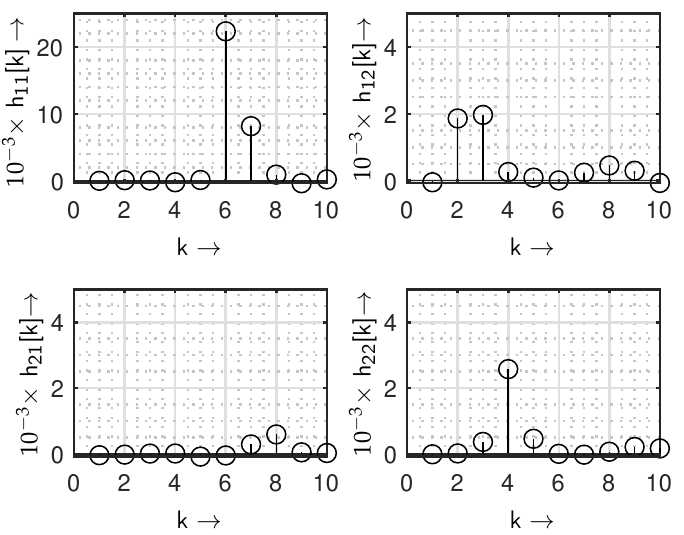
Figure 3. Measured channel impulse response of a 100 m long MMF with respect to the symbol rate f T = 1/ T s = 2.5 GHz at an operating wavelength of 1550 nm.